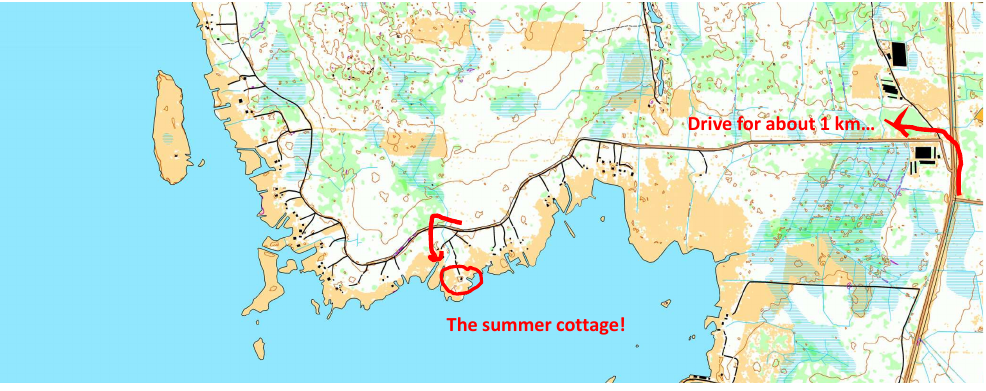
Figure 4: Overlaid graphical annotations (here in red) are good for identifying spatial (and temporal) relations. Map from MapAnt (www.mapant.fi), data from National Land Survey of Finland (www.nls.fi), both provided under the Creative Commons